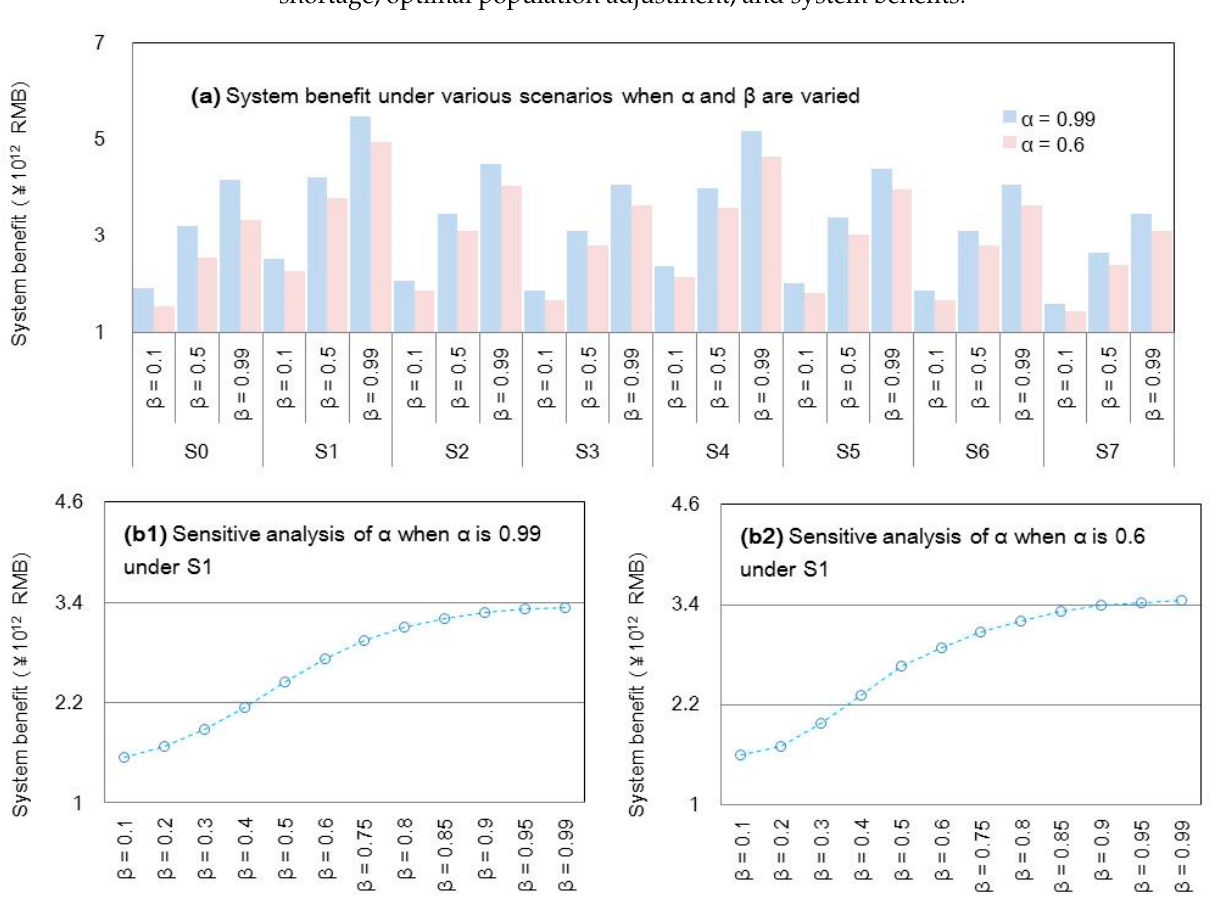
Figure 9. System benefit and risk analysis under S0 to S7.